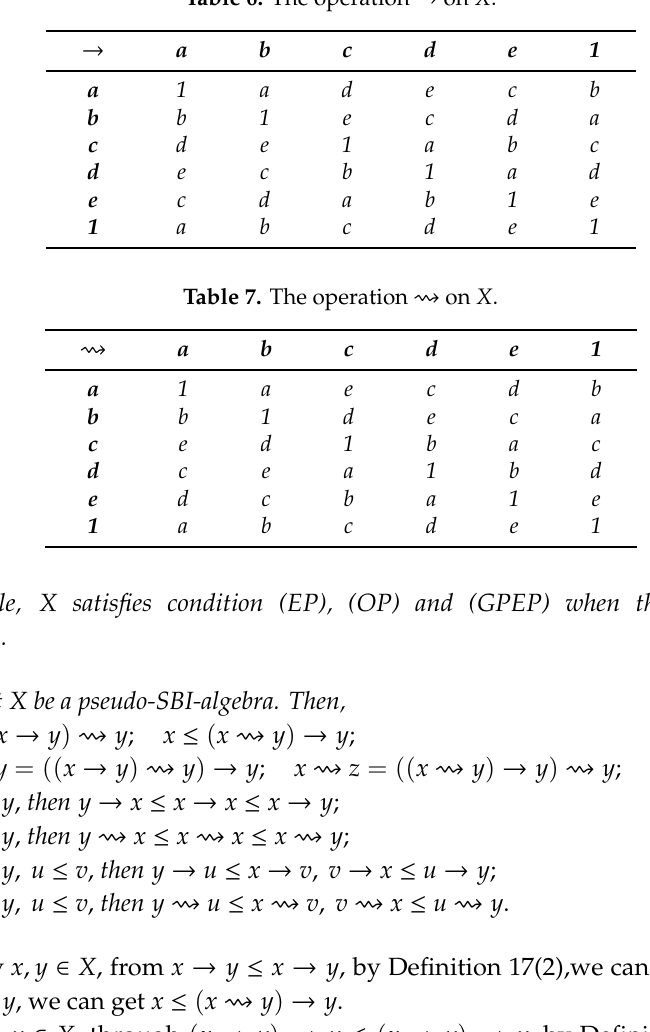
Table 6. The operation → on X .